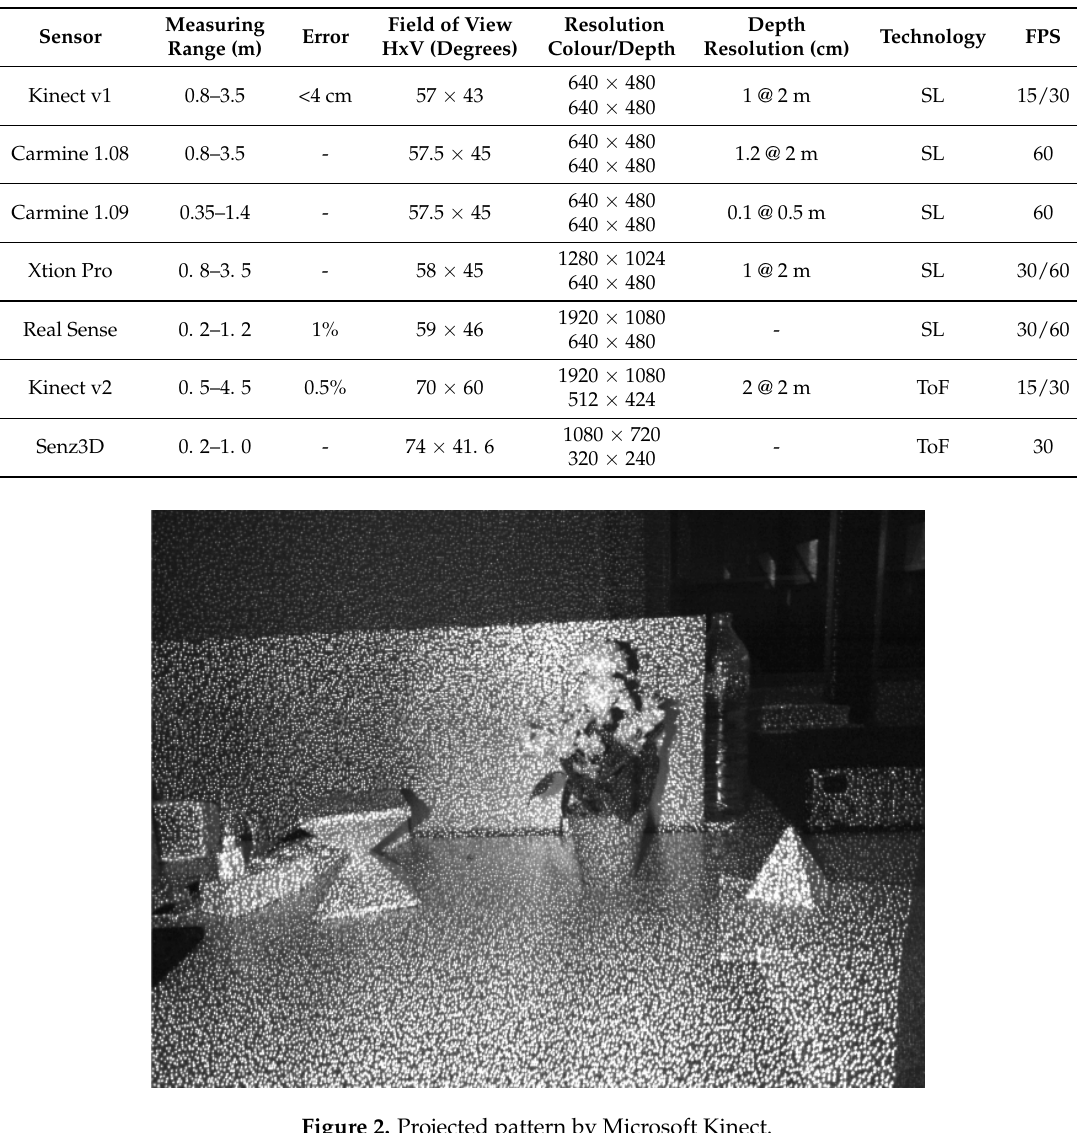
Figure 2. Projected pattern by Microsoft